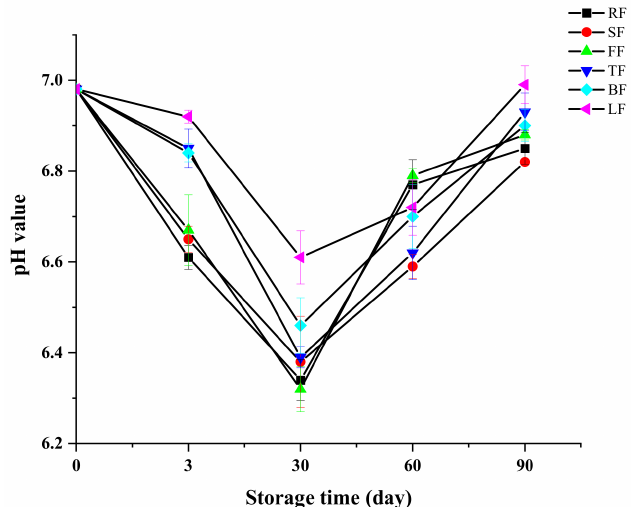
Figure 2. Change in pH value of cuttlefish during storage at − 18 ◦ C by different freezing methods. Error bars show standard